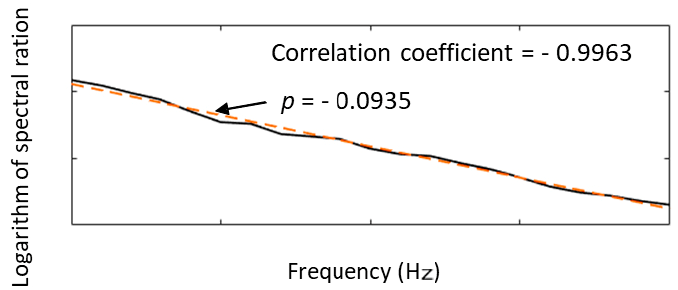
Figure 6. An example of gradient p computation and correlation coefficient of linear approximation. The black solid curve shows the logarithm of the spectral ratio function of frequency (10–30 Hz) in a time window 7.680–8.192 s at the location of CDP1700. The orange broken line is a straight line with gradient p , which was computed by linear approximation with the least squares method. The correlation coefficient of the approximation was − 0.9963.